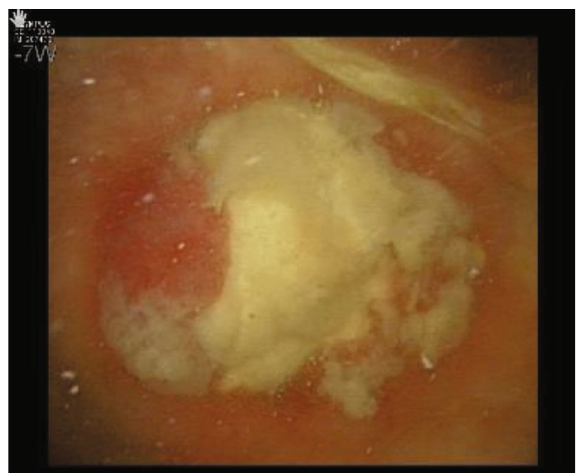
Figure 1: Cystoscopic examination showing a mucinous lesion at the bladder dome.